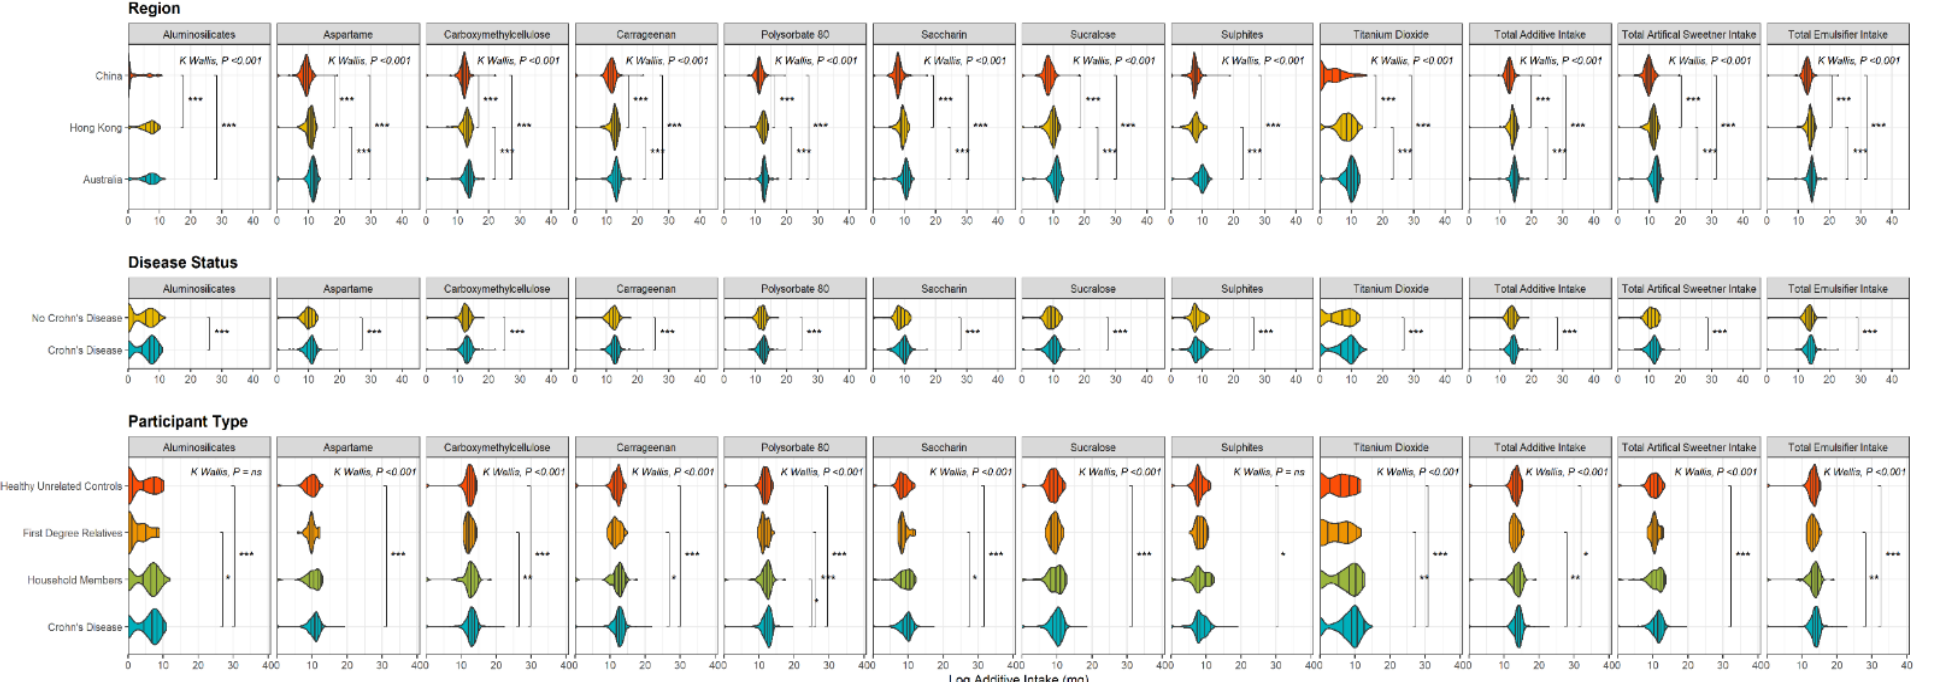
Figure 1. Violin plots showing the distribution of Log-adjusted median additive intake (in milligrams) across additives of interest (as well as total additive intake, total artificial sweetener intake and total emulsifier intake, far right panels) from recent (last 12 months) intake questionnaire, between regions (top panel), for Crohn’s cases compared to all controls (Disease status; middle panel), and between all participant types (bottom panel). Lines represent quantiles (0.25, 0.50, 0.75, 0.95), all p values calculated on unadjusted intake amounts, only significant p values shown (* p ≤ 0.05, ** p ≤ 0.01, *** p < 0.001, ns—not significant Comparisons of ≥ 3 groups performed with Kruskal–Wallis test, between group comparisons calculated with Mann–Whitney U or Wilcoxon sign-rank test.